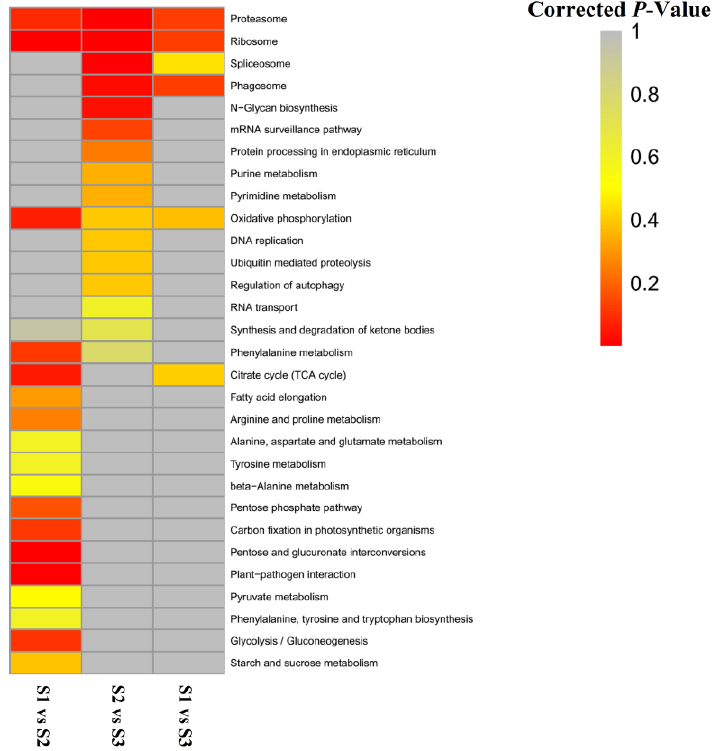
Figure 5. KEGG (Kyoto gene and genome encyclopedia database) enrichment analysis of DEGs. The smaller the p -Value, the closer the color is to red and the more significant the enrichment.